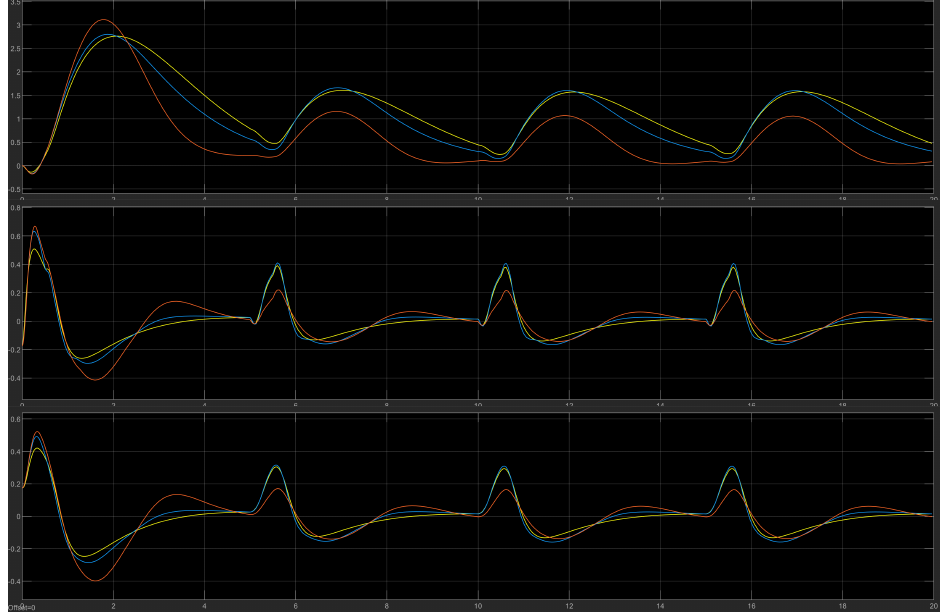
Figure 29. The DIP response under disturbance (second placement point) in the control signal with the LQR (yellow), FLC (blue) and modified FLC* (orange)